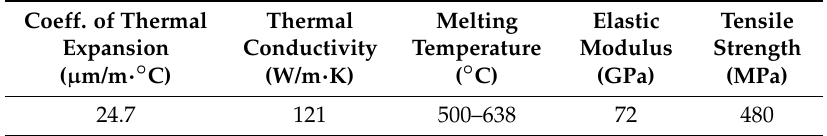
Table 1. Primary physical and mechanical properties of aluminum 2024-T3 at room temperature [17]. Coeff. of Thermal